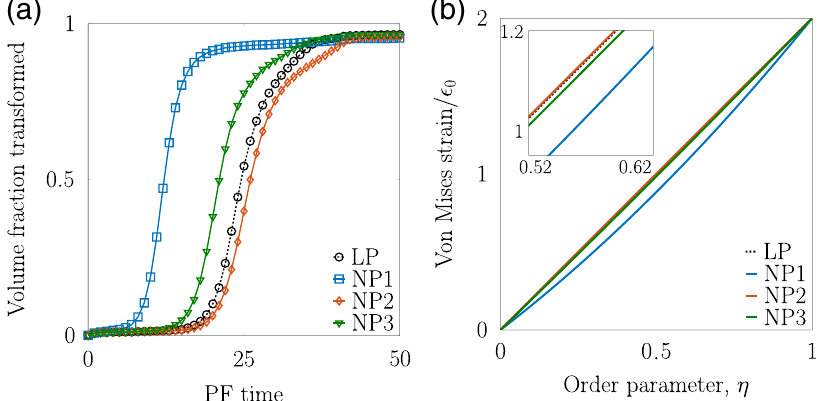
Fig. 3 a Volume fraction of martensite during PF simulations as in cases shown in Fig. 2. b Von Mises strain of transformation strain tensor along different transformation pathways, with inset showing an enlarged portion to indicate the ranking